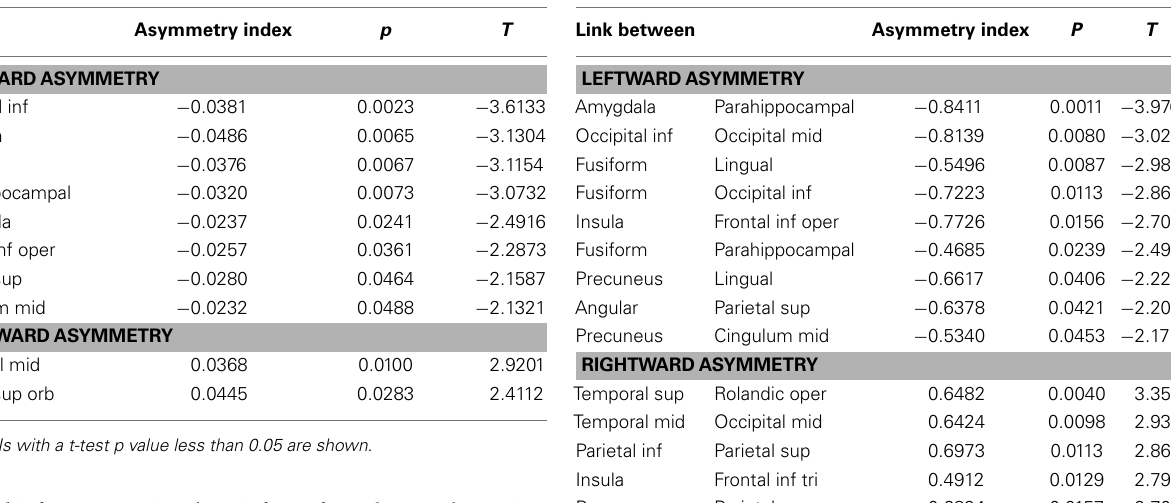
Table 1 |Asymmetry of cortical ROI global connectivity. Table 2 |Asymmetry of cortical